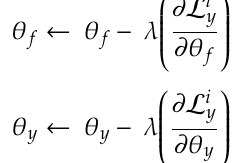
Figure 3. Role of feature extraction and feature selection in the prognostics modeling process.